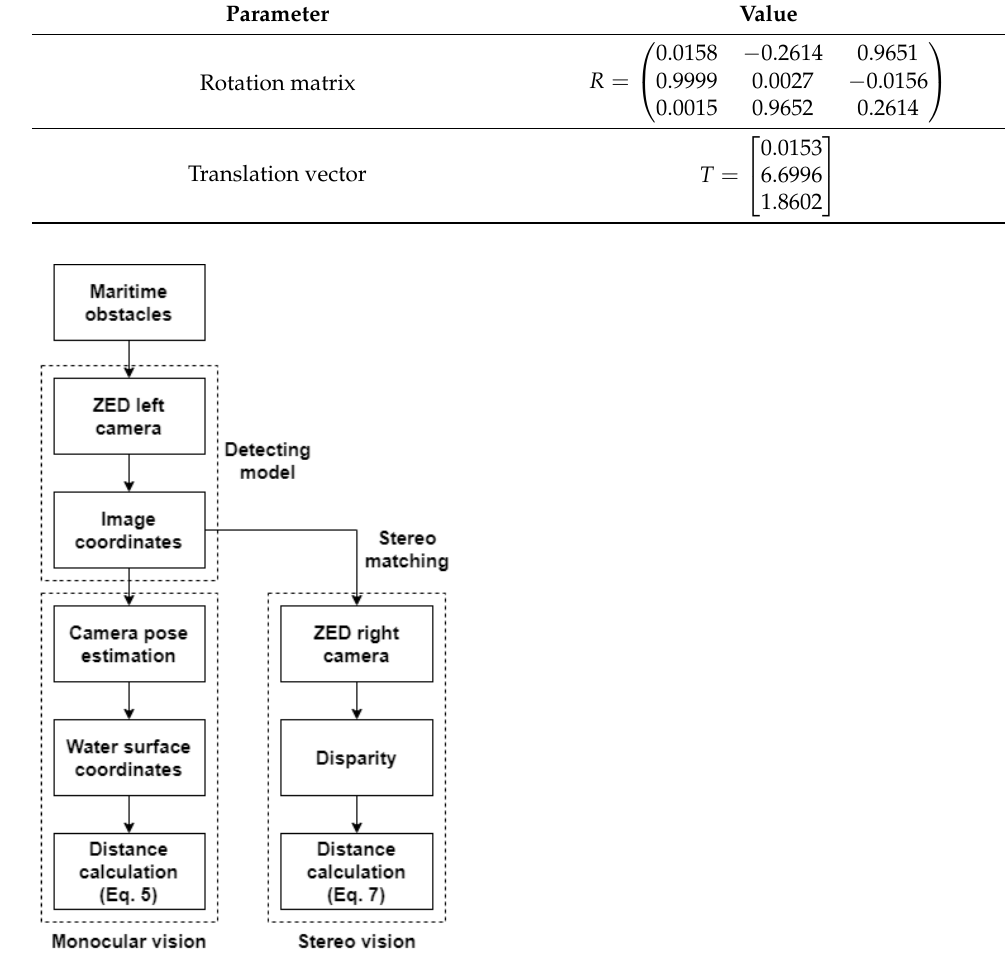
13 of 22 Table 5. Camera parameter information. Parameter